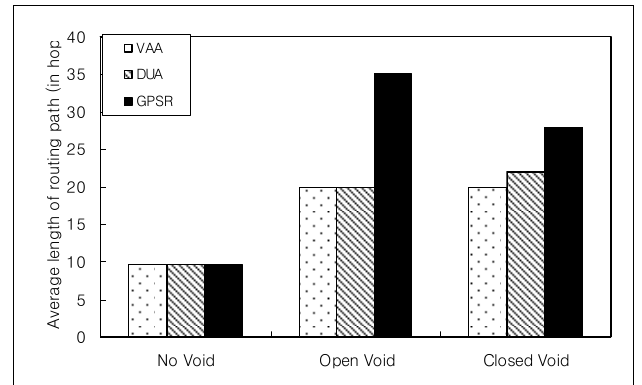
Figure 20. Average length of routing path in different types of void.